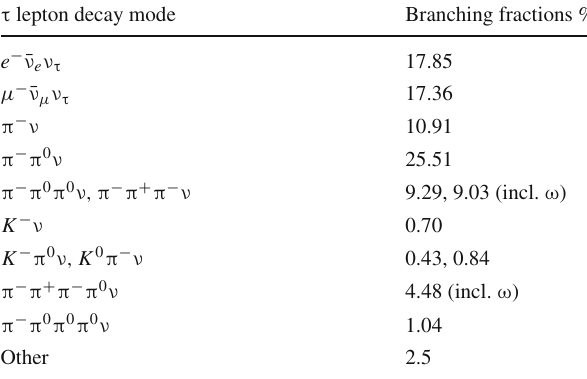
Table 2 Summary of τ lepton decay modes implemented for calcula- tion of polarimetric vectors. Branching fractions for each decay mode according to [37] illustrate the completeness of the algorithm. The “Other” decay modes are treated as unpolarized